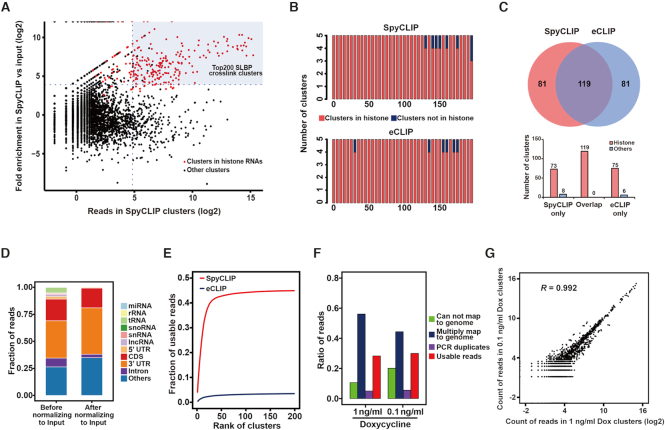
Improved SpyCLIP specificity and sensitivity after background deduction by a universal input library. (A) Fold enrichment for SLBP SpyCLIP clusters relative to the universal input library. The dots in red indicate the clusters overlapping with histone mRNA. The fold enrichment is defined as \documentclass[12pt]{minimal}
\usepackage{amsmath}
\usepackage{wasysym}
\usepackage{amsfonts}
\usepackage{amssymb}
\usepackage{amsbsy}
\usepackage{upgreek}
\usepackage{mathrsfs}
\setlength{\oddsidemargin}{-69pt}
\begin{document}
}{}$\frac{{{\rm{number\ of\ reads\ in\ CLIP\ clusters}}}}{{{\rm{number\ of\ reads\ in\ input\ clusters}}}}$\end{document}, and clusters with a fold enrichment > 15 are defined as SLBP-specific ones. (B) Histograms show the number of clusters located within histone mRNAs in the top 200 SLBP-specific clusters identified by SpyCLIP or eCLIP. The clusters were ranked and binned by their expression levels. (C) Overlap of SLBP-specific clusters identified by SpyCLIP and eCLIP. The number of clusters within histone mRNA or nonhistone RNAs in each section are shown in the lower panel. (D) Genomic distribution of SLBP SpyCLIP clusters before and after input deduction. Most of the noise signals removed by input normalization originated from abundant endogenous rRNAs, tRNAs, snRNAs and snoRNAs. (E) The cumulative fraction of usable reads in the top 200 SLBP-specific clusters identified by SpyCLIP or eCLIP. (F) Composition of sequencing reads from SLBP SpyCLIP libraries at different Dox induction concentrations. (G) Reproducibility of SLBP SpyCLIP reads within the identified clusters from libraries at different Dox induction concentrations.